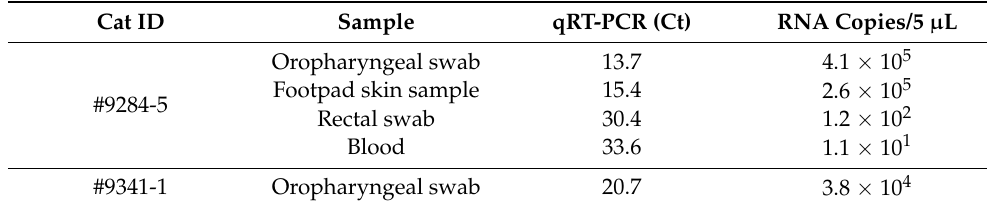
Table 1. Quantification of FCV RNA by qRT-PCR in samples collected from cats #9284-5 and #9341-1.